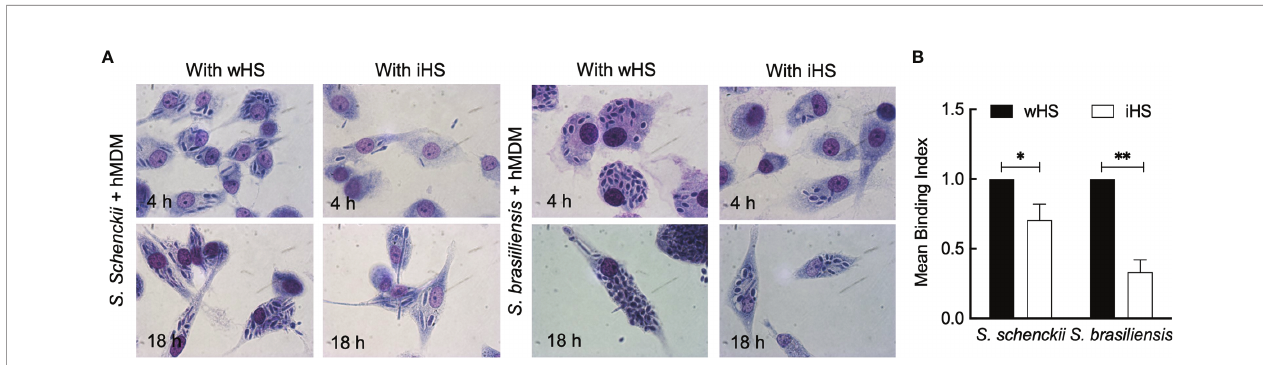
FIGURE 1 | Interaction between the Sporothrix yeasts and human monocyte-derived macrophages (hMDMs). (A) Sporothrix schenckii or Sporothrix brasiliensis yeast cells were made to interact with hMDMs at 37°C in a CO 2 incubator for 4 – 18 h in medium containing whole human serum (wHS) or heat-inactivated human serum (iHS). Optical photomicrographs were recorded at ×100 magni fi cation; at least three biological replicates, each in duplicate, were performed. (B) hMDMs were infected with FITC-labeled yeasts of S. schenckii or S. brasiliensis in the presence of wHS or iHS for 1 h at 37°C in a CO 2 incubator, washed with PBS, incubated for 15 min with Trypan blue, washed, and subjected to fl ow cytometry after gently releasing hMDMs from the wells using a cell scraper. Results are mean ± SD of three experiments (**p < 0.001 and *p <